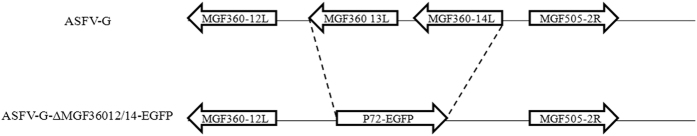
Schematic representation of the MGF360-13L and MGF360-14L gene regions deleted in ASFV-G-ΔMGF36013/14 and replaced with the p72EGFP reporter gene cassette.